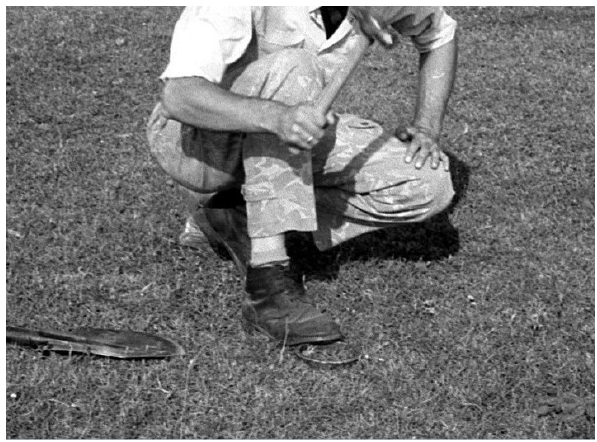
Figure 2. Soil sampling using a ring of 14cm diameter to collect a 5cm deep soil core (courtesy of UIAR,